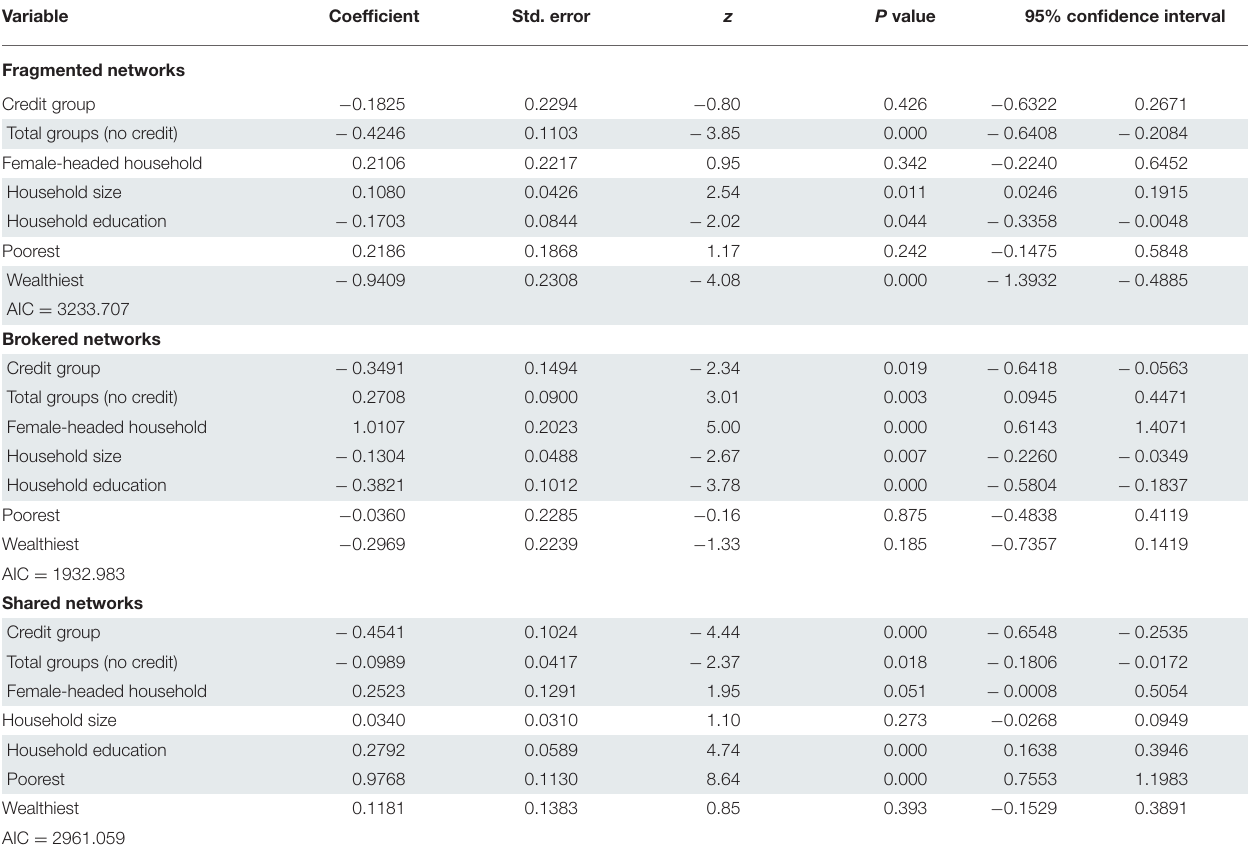
TABLE 3 | Generalized linear model results of food insecurity as a function of credit group membership and total group membership.